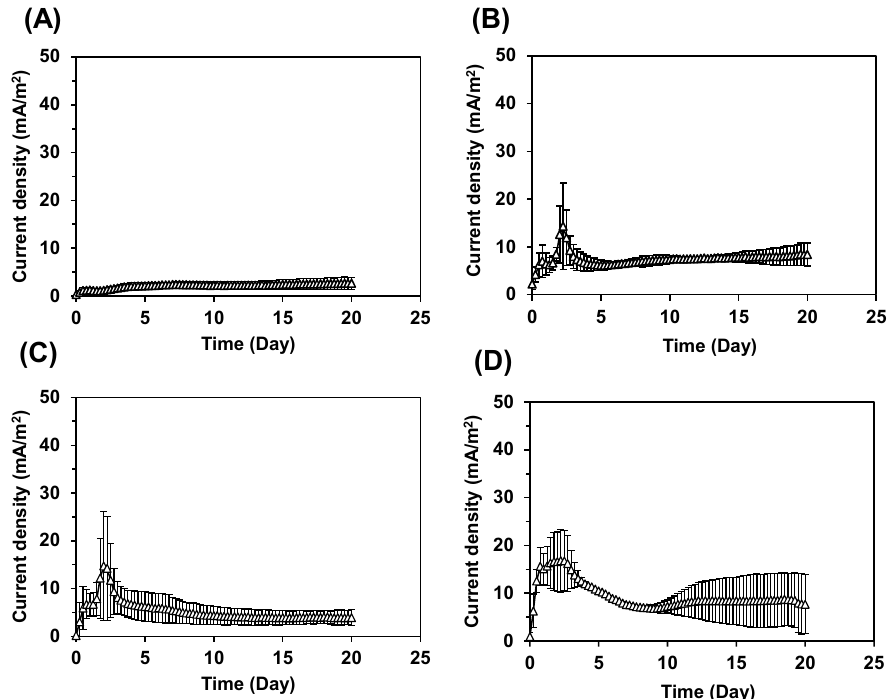
Figure 3. The current density of reference experiments. Compared to the bMFC used in Figure 2; ( A ) without any microorganism, ( B ) without iron (III) hydroxide, ( C ) using cation exchange membrane instead of the bipolar membrane, ( D ) opposite direction of bipolar membrane. Figure 3C depicts the result of using a cation exchange membrane instead of the bipolar membrane of the bMFC shown in Figure 2. In this case, the protons generated Table 1. Conditions for four control experiments. moved from the anode chamber to the cathode chamber via the cation exchange